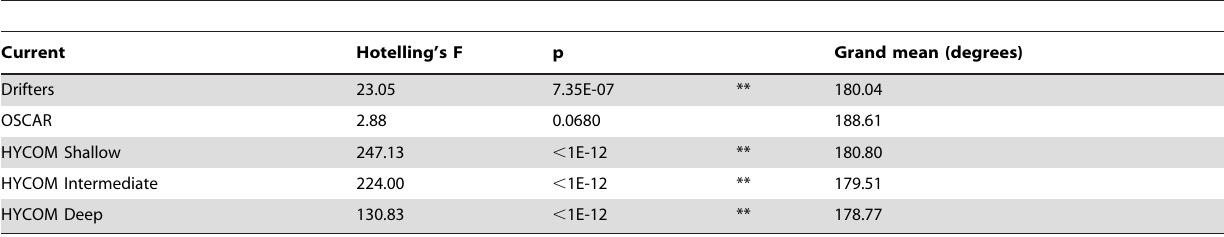
Table 4. Summary of Batschelet second-order statistical analysis of directional uniformity applied to the daily difference between the directions of swimming and prevailing current.